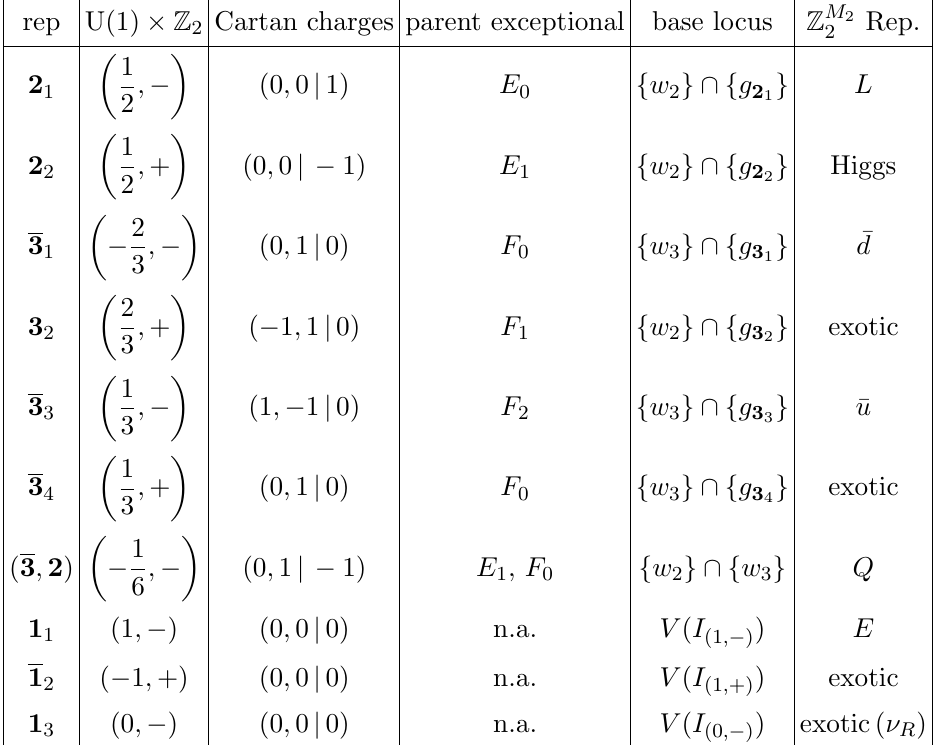
Table 3 . States and charges associated with the matter surfaces. The polynomials g i de(cid:12)ning the matter curves in the base are in equation (3.13). We have included the identi(cid:12)cation with